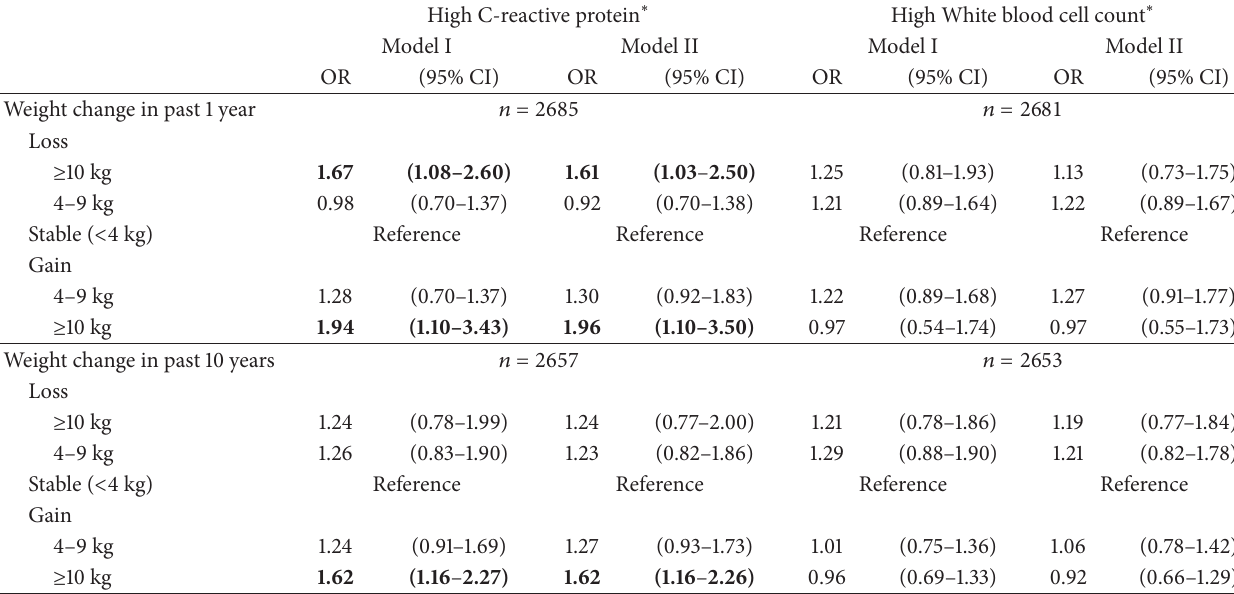
Table 3: Odds ratios from logistic regression models predicting high levels of C-reactive protein and White blood cell count by 1- and 10-year change in weight